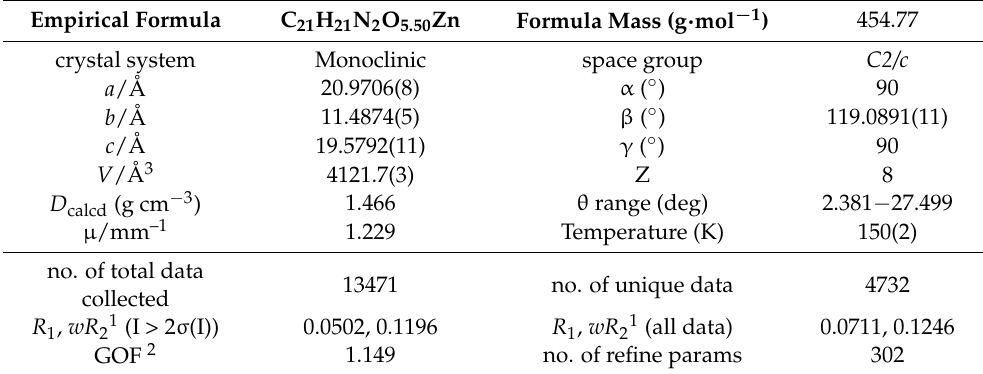
Table 4. Crystal data and other pertinent information of compound 1